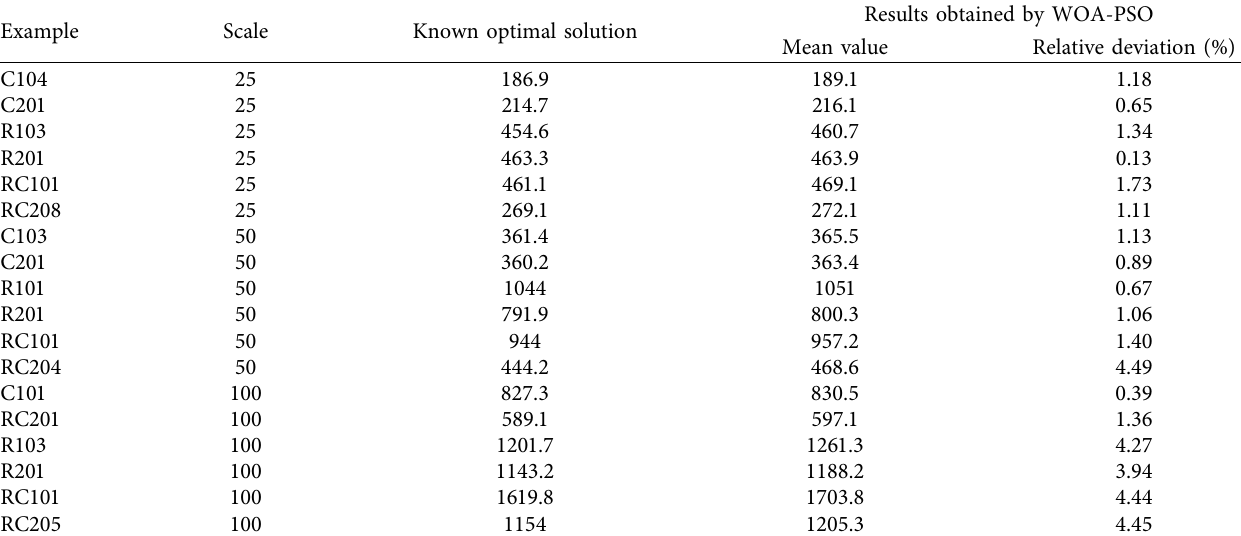
Table 3: Solving the Solomon example with the WOA-PSO